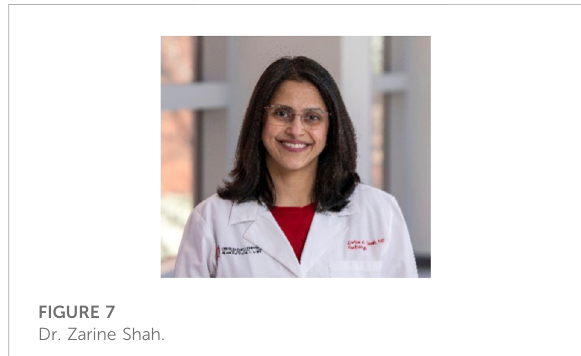
FIGURE 7 Dr. Zarine Shah.